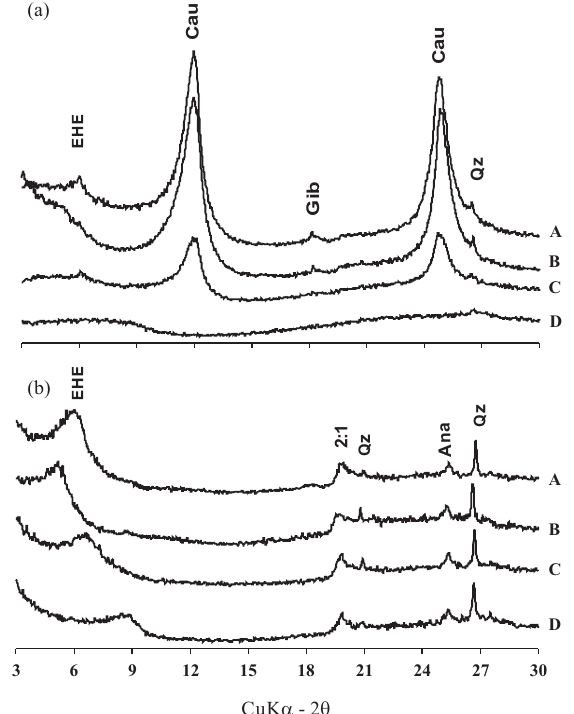
Figura 1. Difratogramas de raios X da fração argila orientada do horizonte A do Chernossolo Argilúvico (perfil 3, MT1), mostrando a variação na mineralogia promovida pelos tratamentos com DCB (a) e com DCB+NaOH 5 mol L